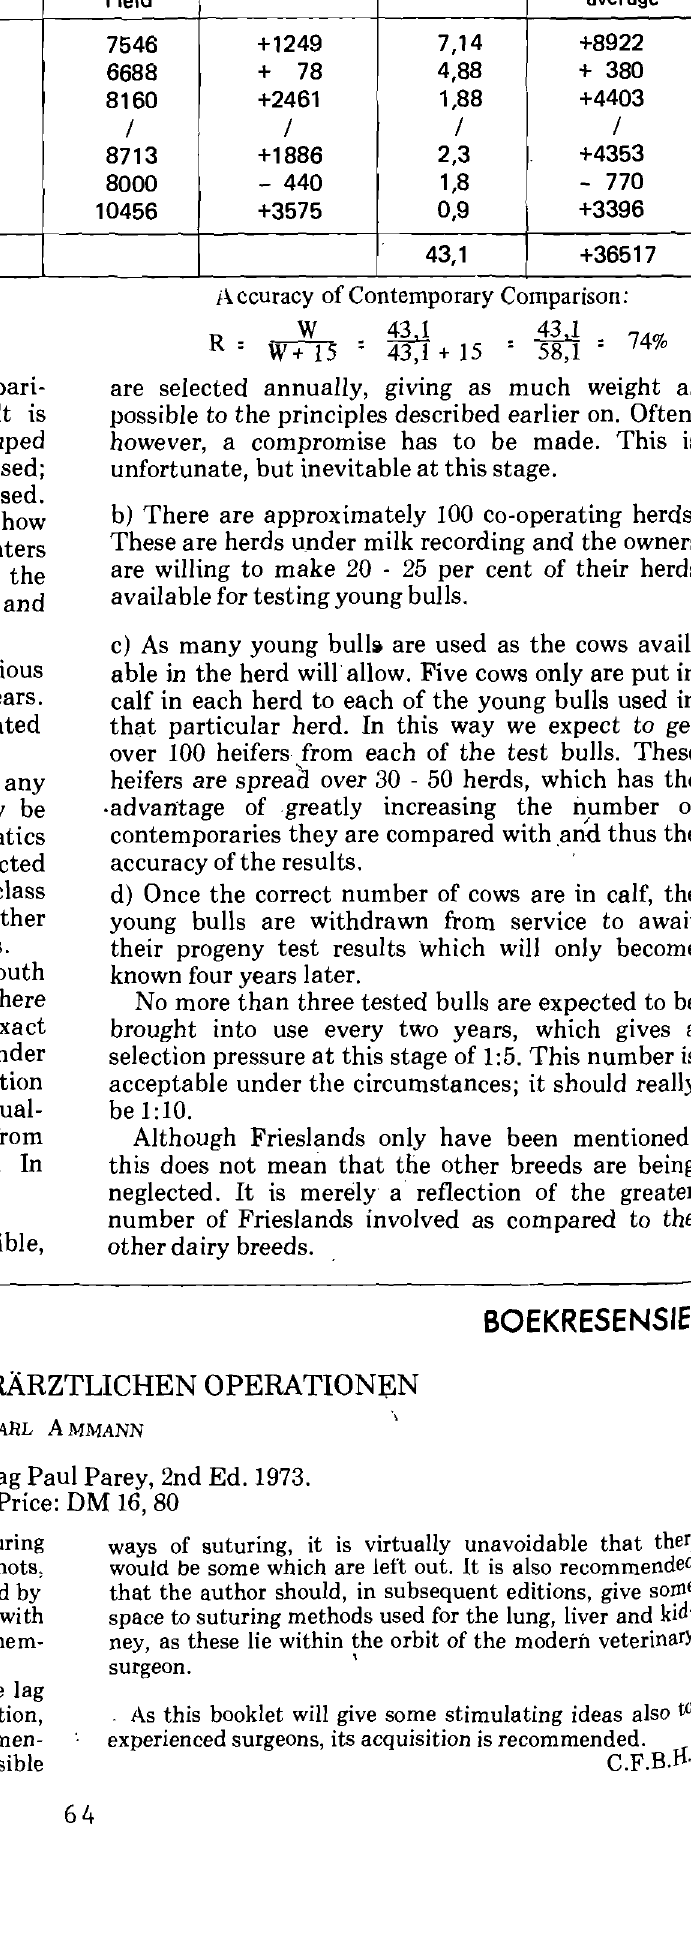
Table 8: CONTEMPORARY COMPARISON FOR THE BULL